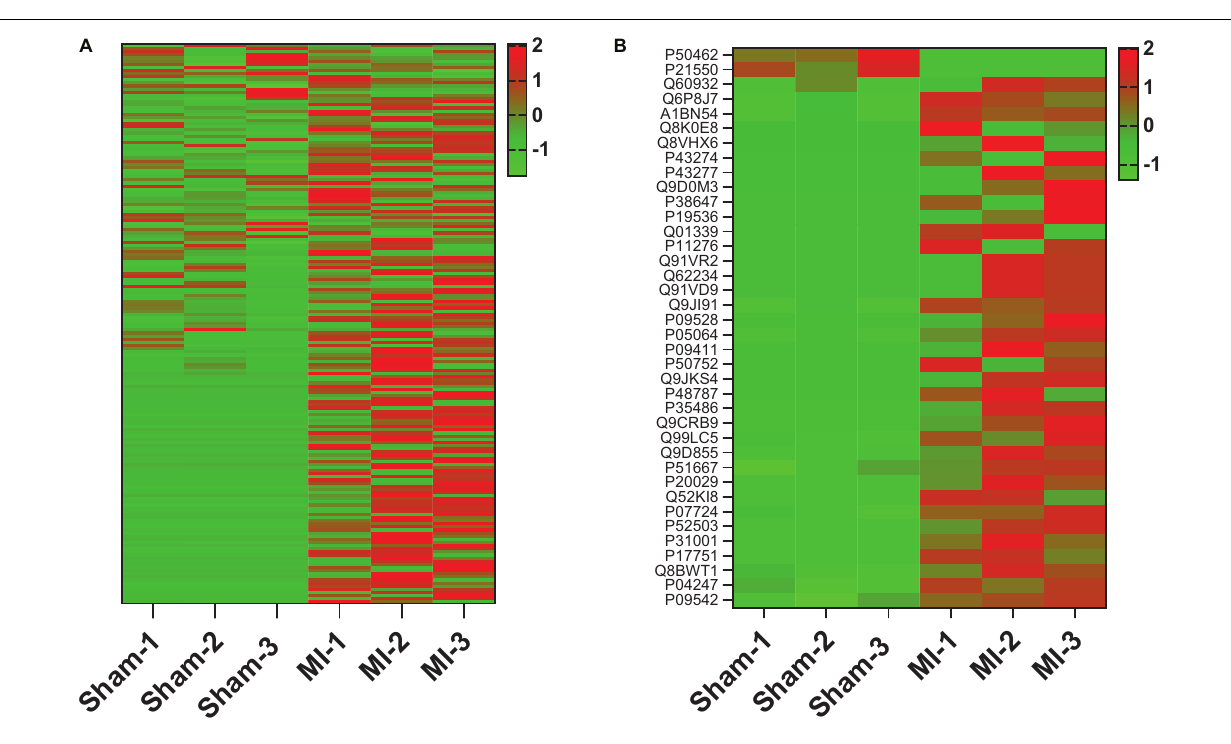
Frontiers in Cell and Developmental Biology |